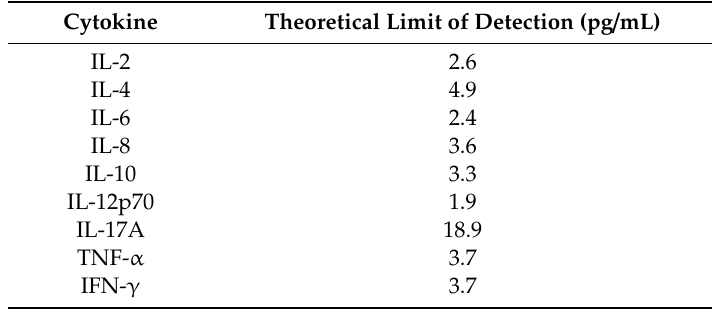
Table 1. Theoretical limit of detection for cytokines analyzed in the study.